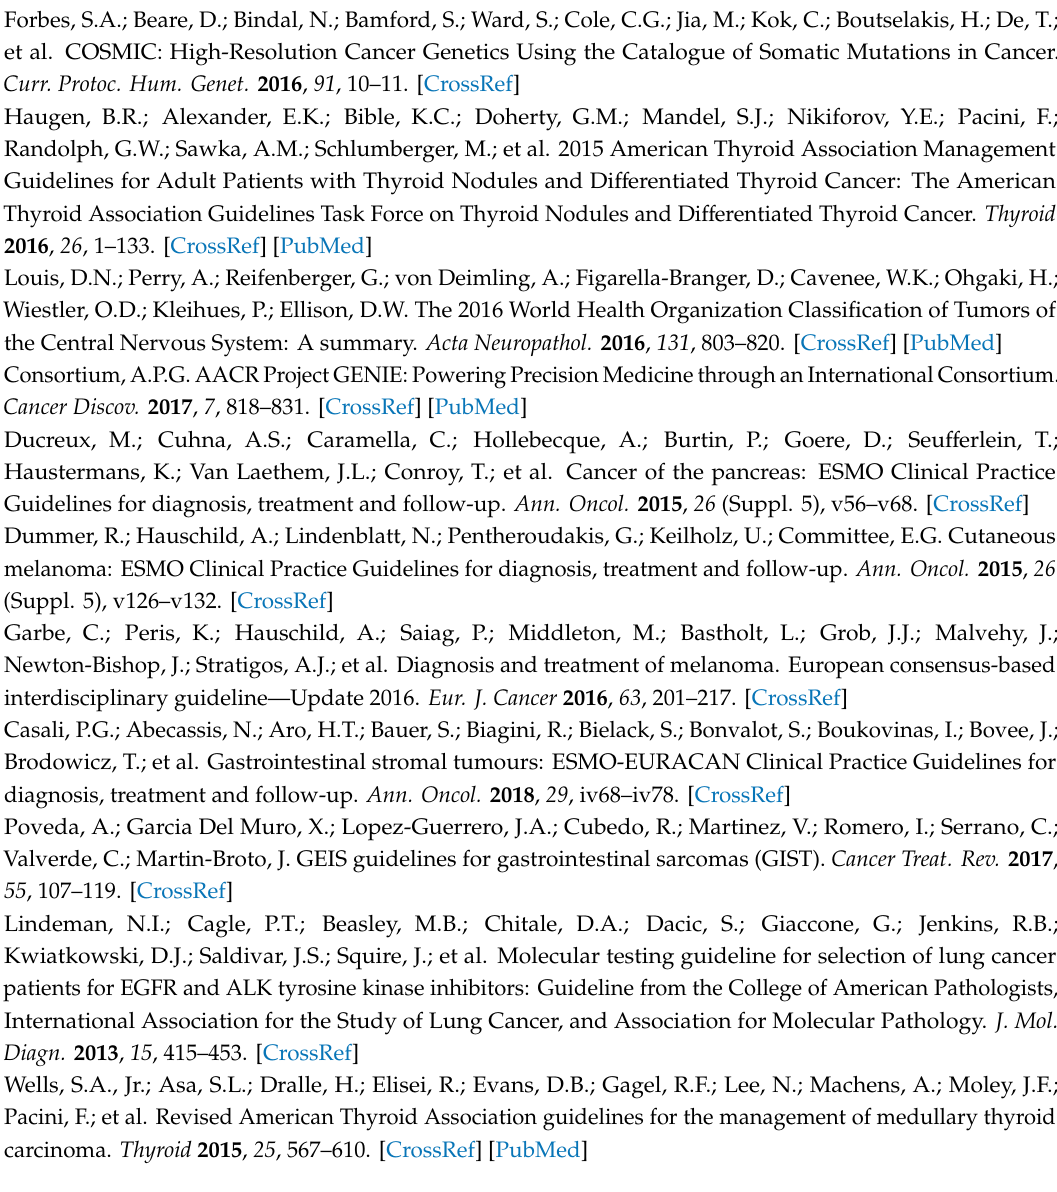
Figure S1: Median coverage for gene target regions, Figure S2: Frequency of IDH1 and IDH2 mutations in CNS tumor samples, Figure S3: Frequency of EGFR and KRAS mutations in NSCLC samples, Figure S4: Frequency of KRAS, NRAS and BRAF mutations in CRC samples, Figure S5: Frequency of mutations in Thyroid nodules, Figure S6: Frequency of mutations in Melanoma samples, Figure S7: Frequency of mutations in Pancreatic lesions, Table S1: Median coverage for gene target regions, Table S2: Details of mutations detected in samples